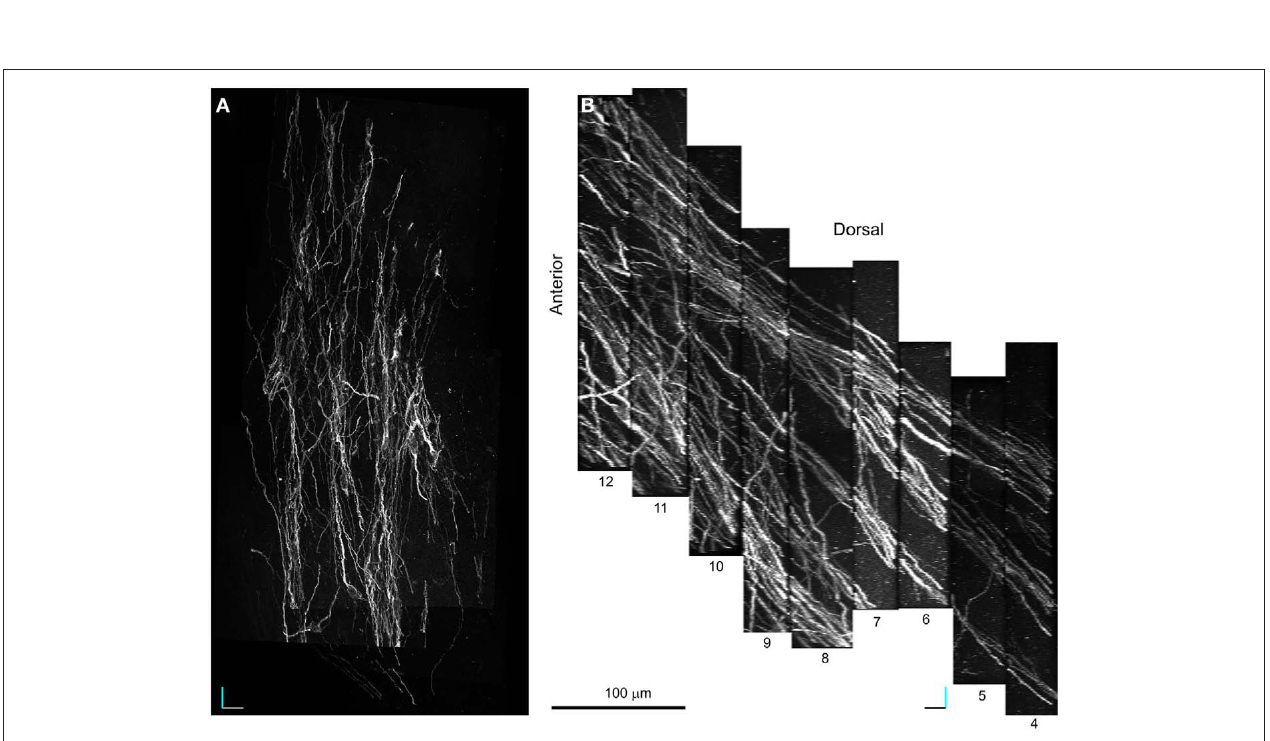
Figure 5 | Three-dimensional reconstruction of four fascicles of DCX + processes. (A–C) . Four fascicles of DCX + processes were traced in the stack shown in Figure 4 . Each fascicles is represented by a different color and its tracts running within the EC are in darker colors. The 3D model was rendered in Blender (www.blender.org). In A the front view of the 3D model is superposed to an inverted image of the MIP of the stack along the z -axis. (B) medial view. (C) Caudal